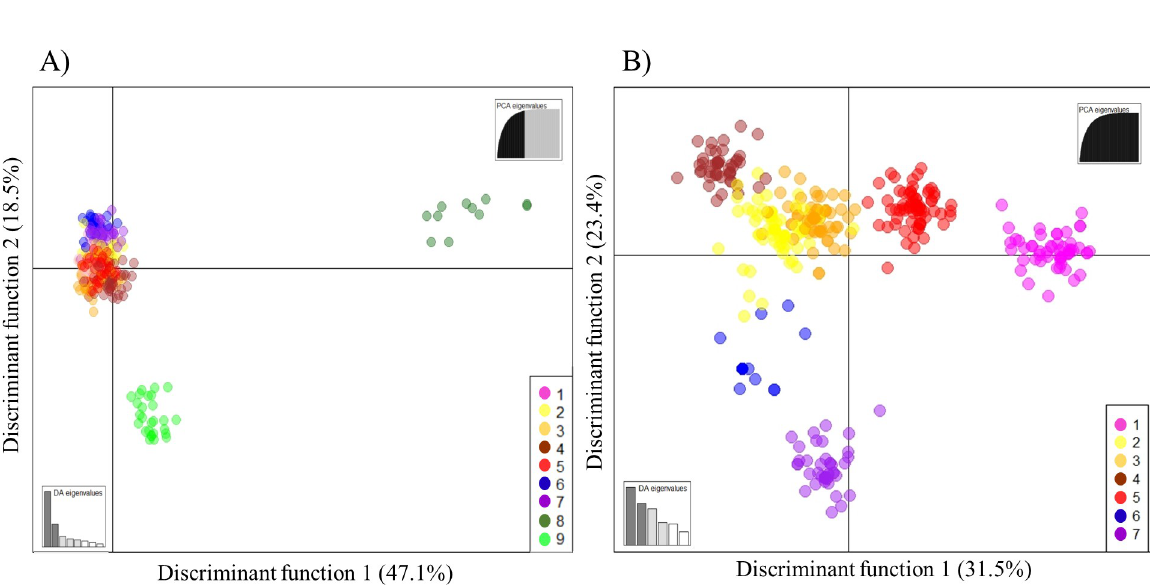
Fig 4. DAPC scatterplots based on the K-means algorithm used to identify the proper number of clusters. Dots represent individuals, and the clusters are presented in different colors. The accessions were allocated into nine clusters: 1 (magenta), related to the Seibel series; 2 (yellow), related to table grape accessions of V . vinifera ; 3 (orange) and 5 (red), related to wine grape accessions of V . vinifera ; 4 (brown), predominance of IAC hybrids; 6 (blue) and 7 (purple), related to the species V . labrusca ; 8 (dark green), related to wild Vitis species; and 9 (green), V . rotundifolia accessions. (A) DAPC with all samples included. (B) DAPC excluding clusters 8 and